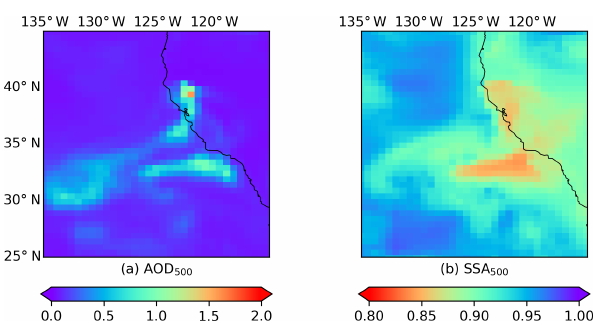
Figure C3. MERRA-2 M2T1NXAER averaged between 12:00 and 15:00LT for the Californian fire event on 10 November 2018: (a) AOD at 500nm; (b) SSA at 500nm.